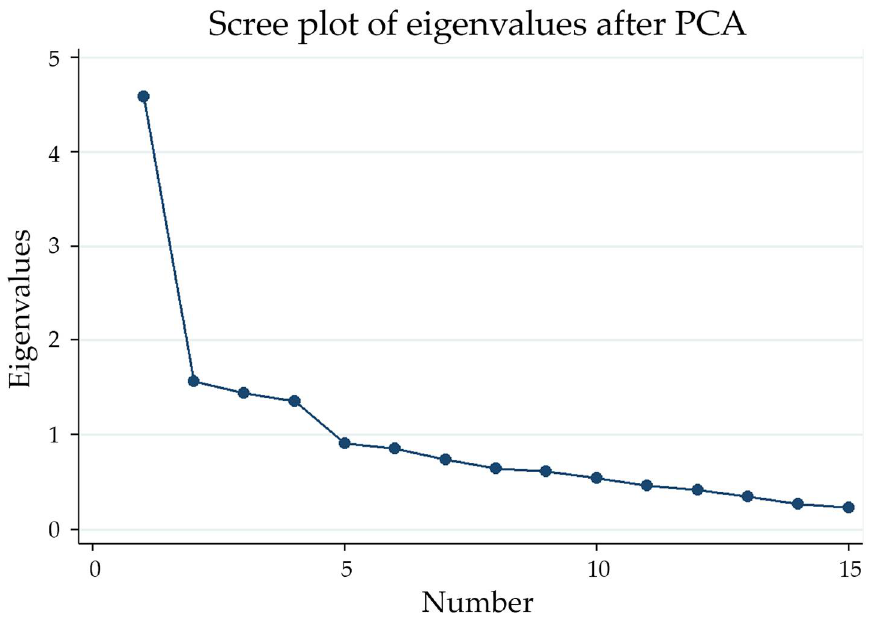
Figure 1. Scree plot of the Arabic version of the Parent Attitudes About Childhood Vaccines (PACV) scale. PCA, principal component analysis.